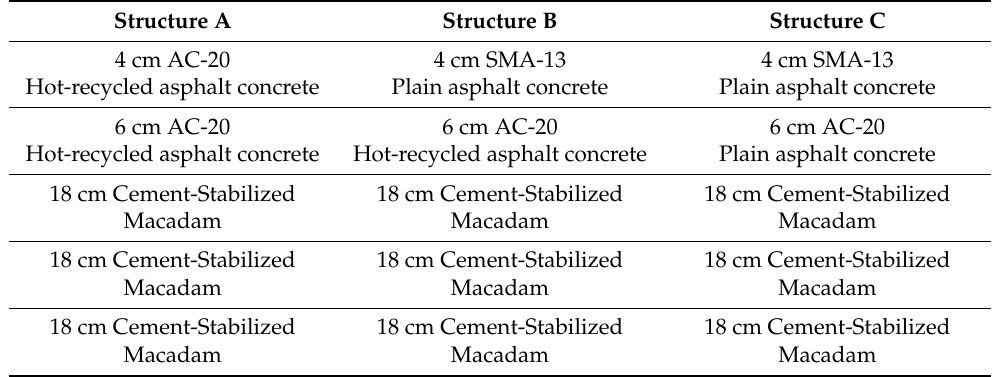
Table 1. Types of road surface structures.